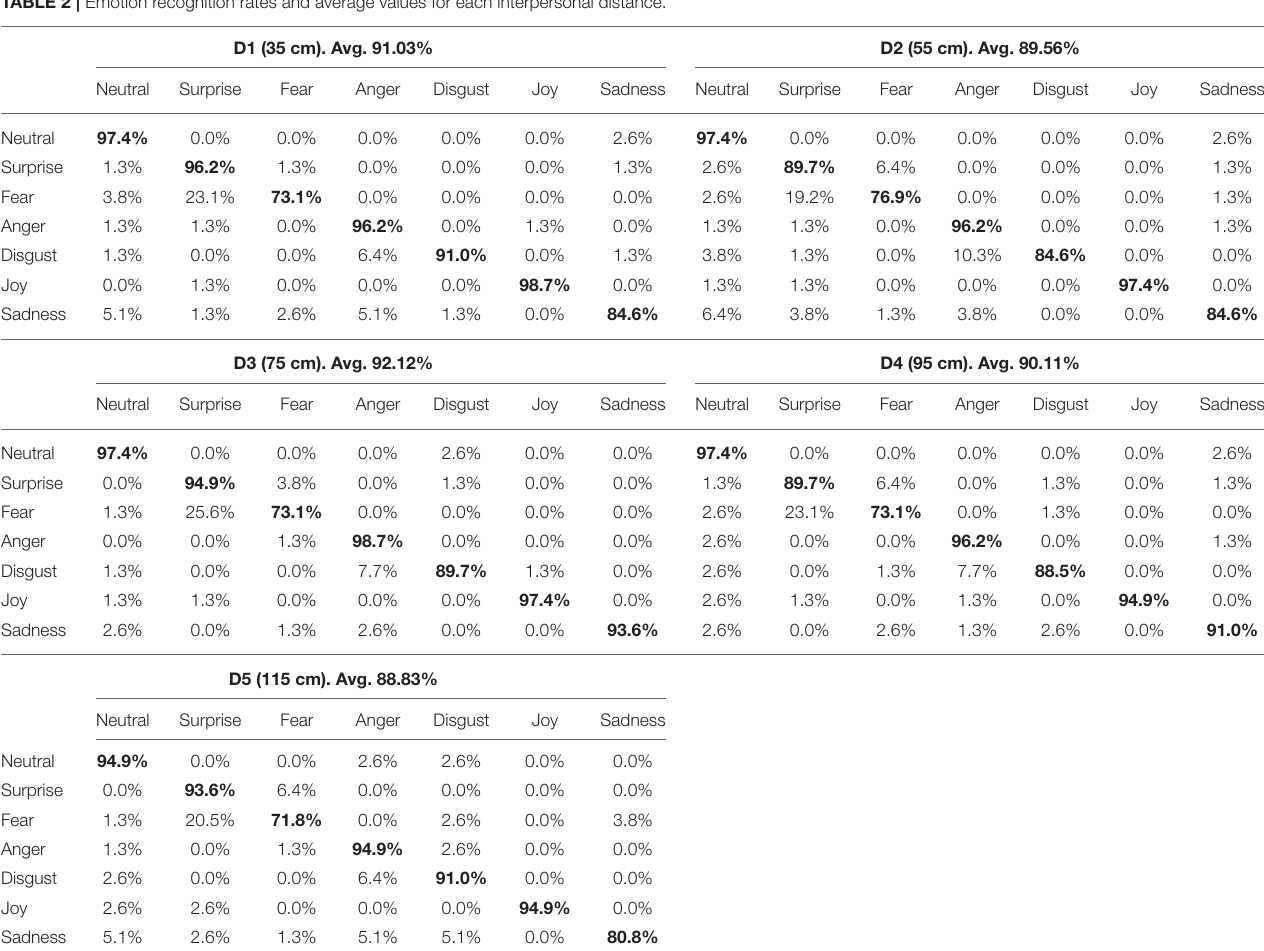
TABLE 2 | Emotion recognition rates and average values for each interpersonal